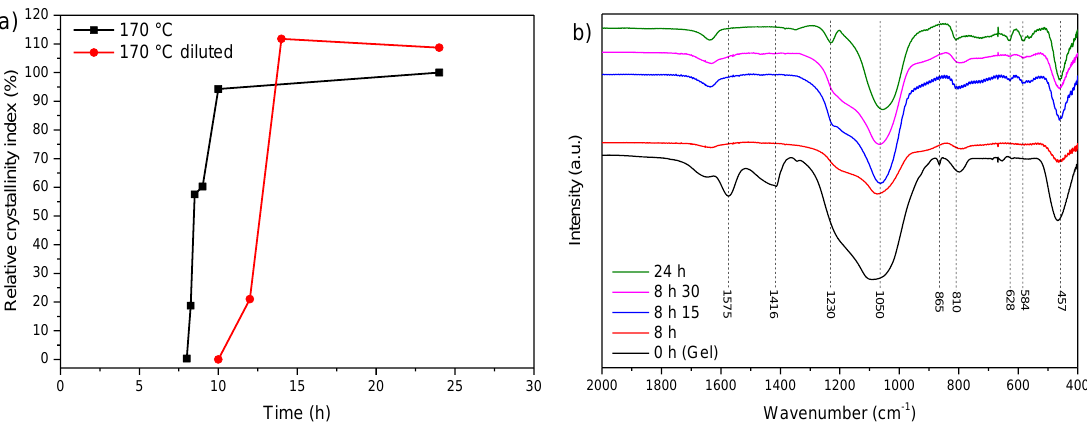
Figure A1. ( a ) Comparison of the crystal growth curves at 170 °C and 150 °C; ( b ) IR spectra accom- panying the synthesis at 170 °C.